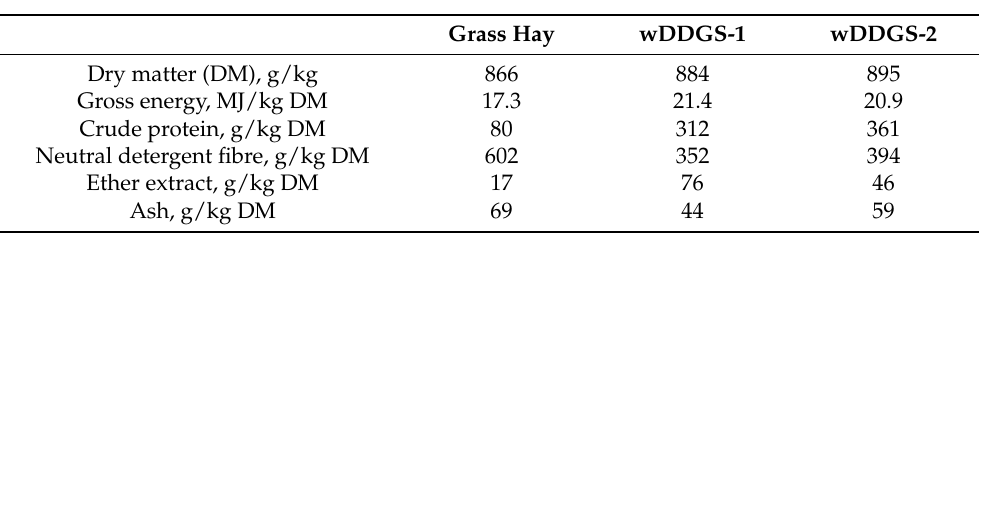
Table A1. Composition of grass hay, wDDGS-1 and